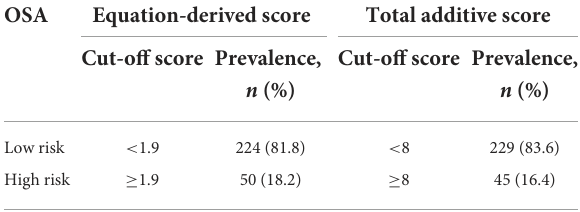
TABLE 1 Demographic and clinical characteristics of the pediatric ADHD cohort ( n = 274).